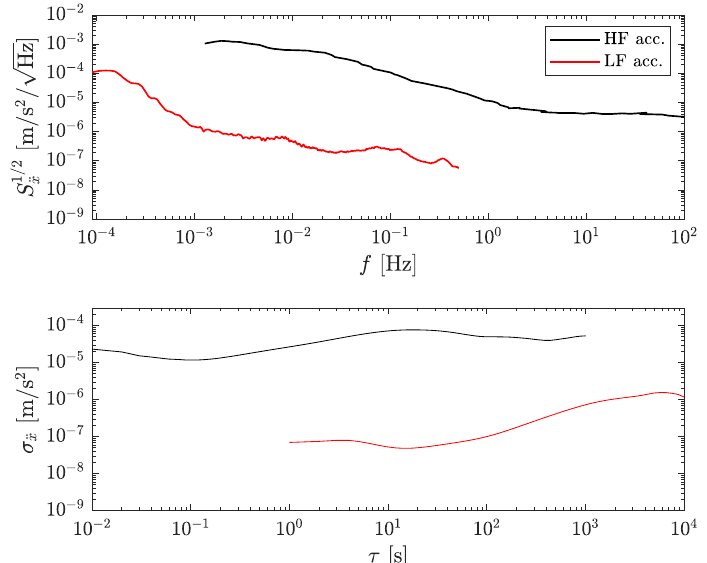
Figure 2. Measured accelerometers’ noise levels. Top: square root of the PSD. Bottom: overlapping Allan deviation. HF: high-frequency accelerometer (black). LF: low-frequency accelerometer (red). The curve for the HF accelerometer represents its actual noise. The curve for the LF accelerometer includes signal and noise and thus indicates a conservative upper limit of its actual noise